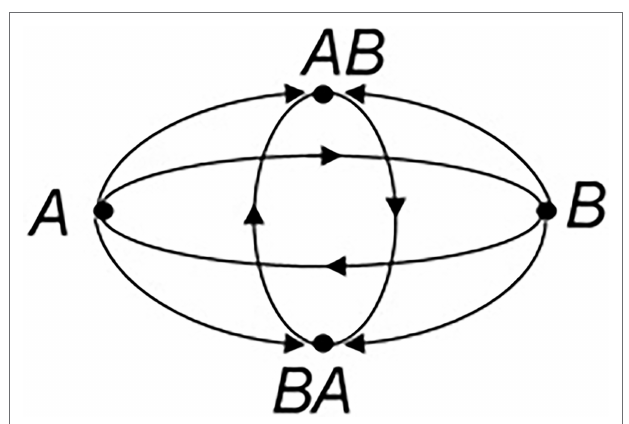
FIGURE 1 | The structure of dialectical cycle D 2